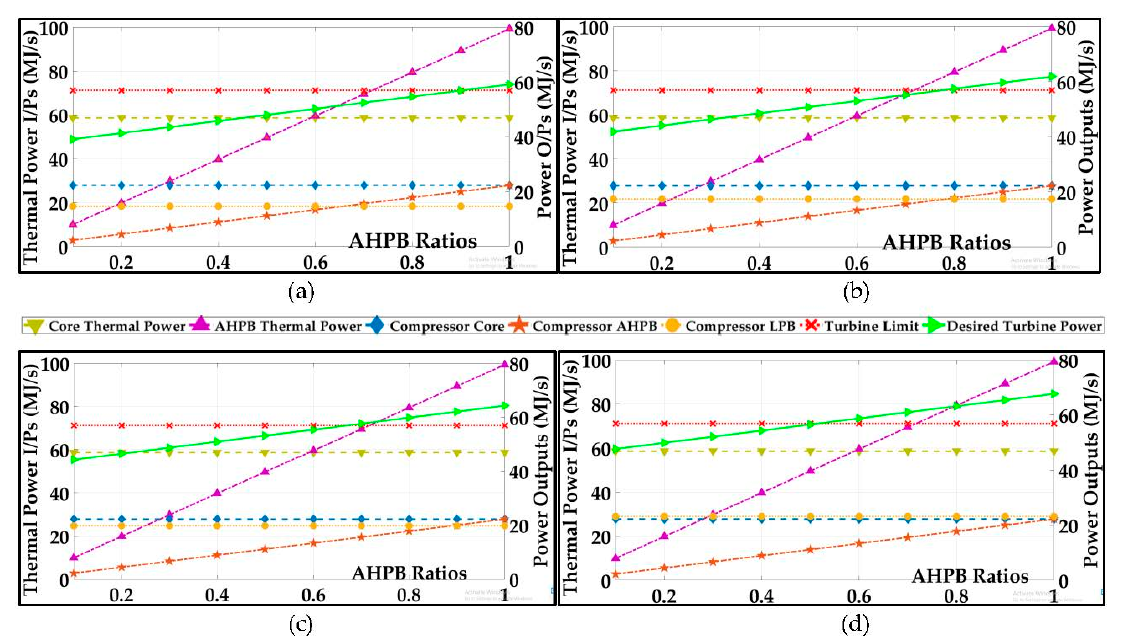
Figure 6. Plots of power input and output vs. AHPB ratios for ( a ) LPB = 2; ( b ) LPB = 6; ( c ) LPB = 10; ( d ) LPB = 12.